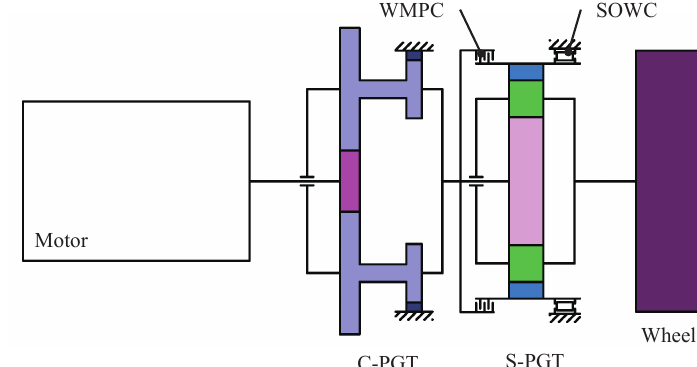
Figure 1. Block diagram of IW-AMT.